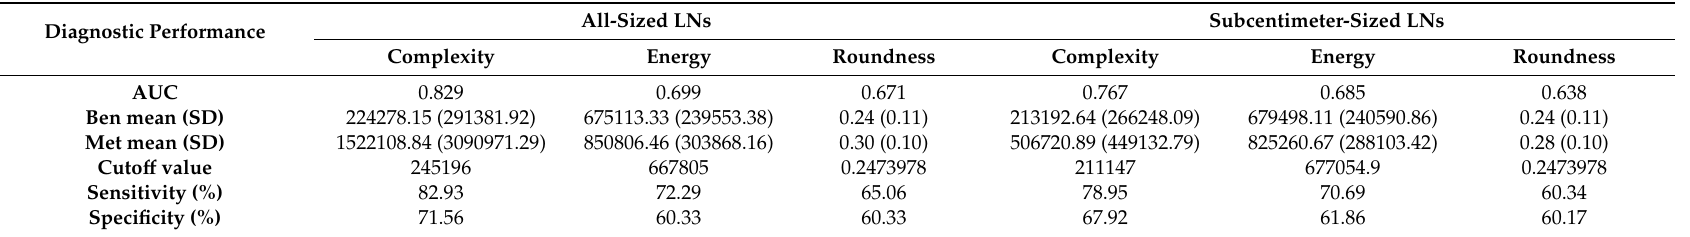
Table 2. Cuto ff value and corresponding sensitivity, specificity for ADC texture